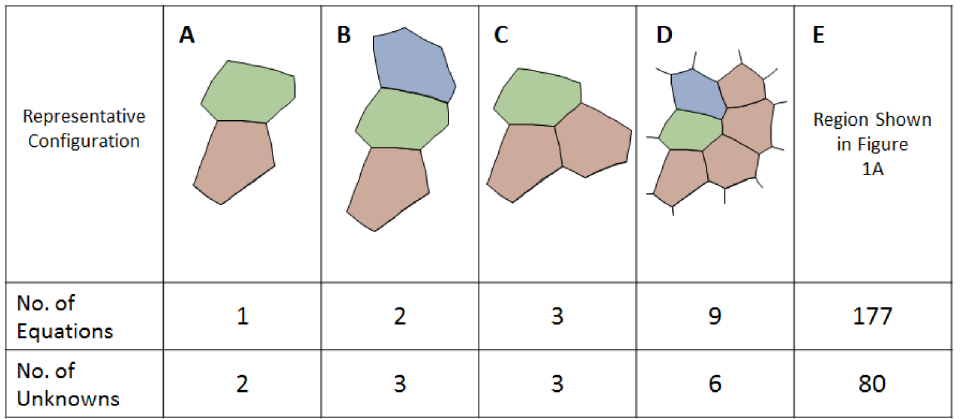
Figure 4. The pressure equations are generally overdetermined. As the number of cells increases and cells acquire multiple neighbours, the Pressure Equations become increasingly well determined ( A to E ). Even when the system is seemingly overdetermined ( D and E ), external data still is needed to ascertain the pressure offset (see text).